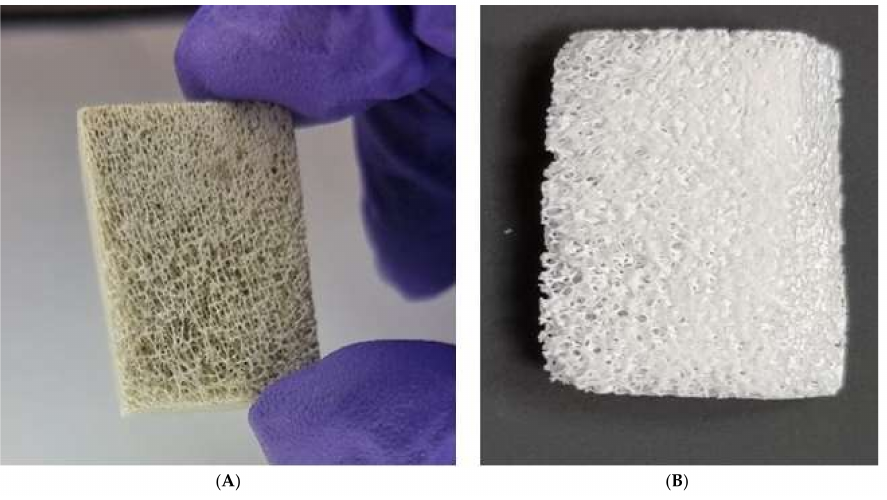
Figure 2. ( A ) Bone cubes after defatting and ( B ) Bone cubes after sintering.